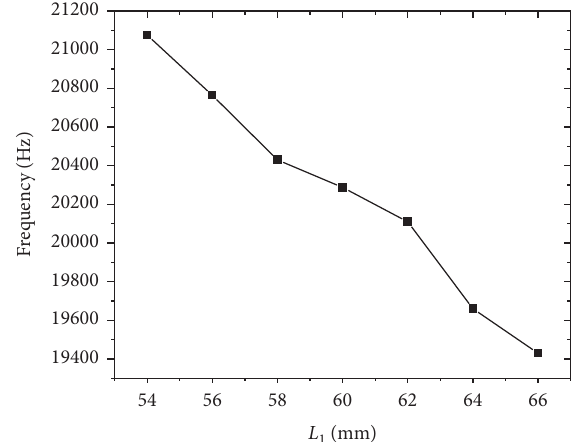
Figure 8: The effect of the length L 1 of the small end cylinder of the compound horn on vibration frequency.